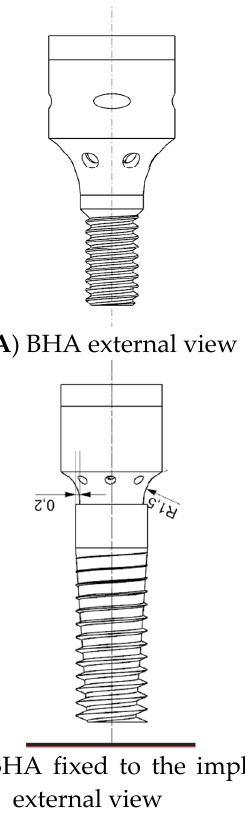
Figure 2. Technical data of the bioactive healing abutment scheme.